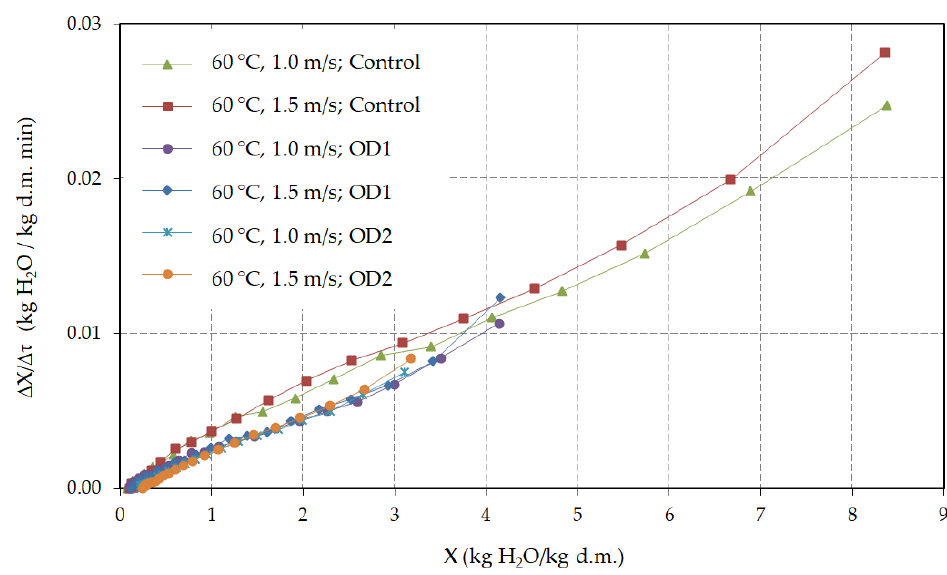
Figure 6. Drying rate of apricot halves during HAD for the air temperature of 60 °C; 1.0 and 1.5 m/s air velocity.